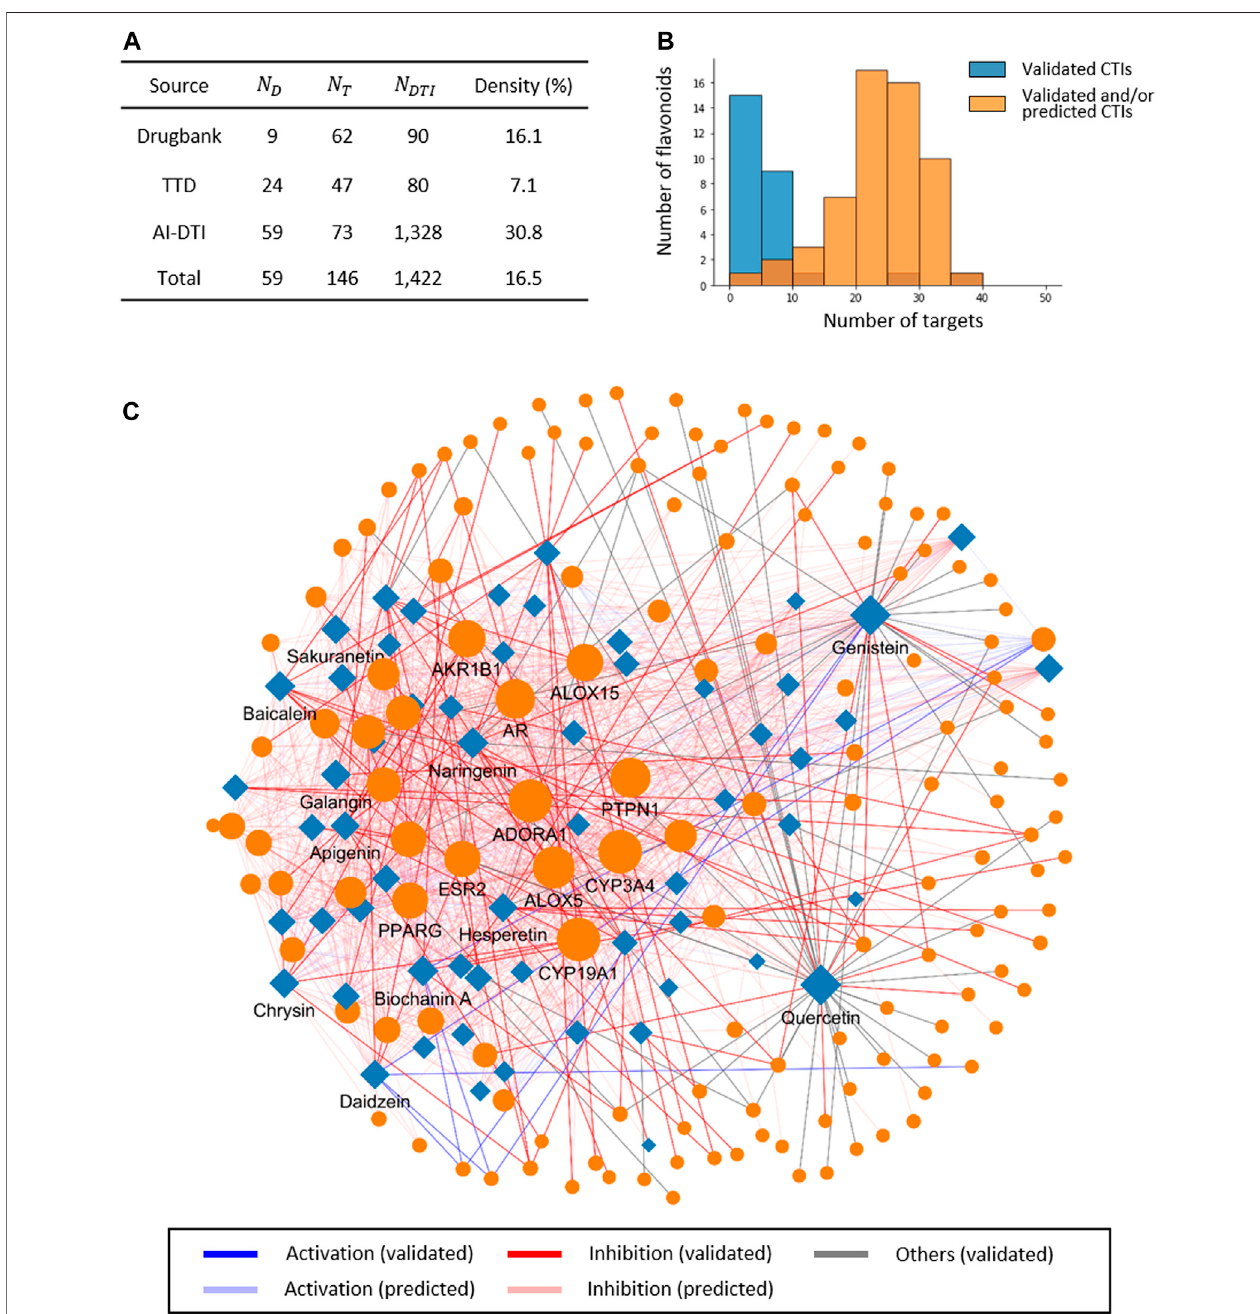
FIGURE 3 | A compound-target network for selected fl avonoids and its property. (A) Statistics of experimentally validated and/or predicted compound-target interactions (CTIs) for fl avonoids. DrugBank and TTD contain experimentally validated DTIs, and AI-DTI is employed to predict the activity-inhibitory target of fl avonoids. (B) Distribution of the number of fl avonoid targets. (C) Compound-target network for fl avonoids. Circles and diamonds denote protein targets and compounds, respectively.